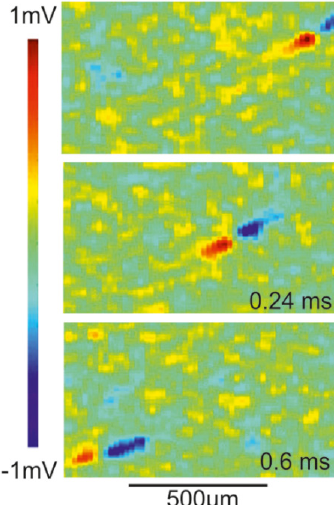
Figure 12. Transistor recording of propagating action potential in a rabbit retina [51]. Color-coded maps of the apparent changes of the gate voltage δ V EOMOS recorded with an array of EOMOS transistors at three different times. The action potential propagates from right to left at a velocity of 1.5 m/s . The waveform is biphasic positive-negative and represents the profile of a current-induced extracellular voltage with EOMOS “ V E . Peak and trough are separated by 120 µ m in space corresponding to a separation of 80 µs in time.